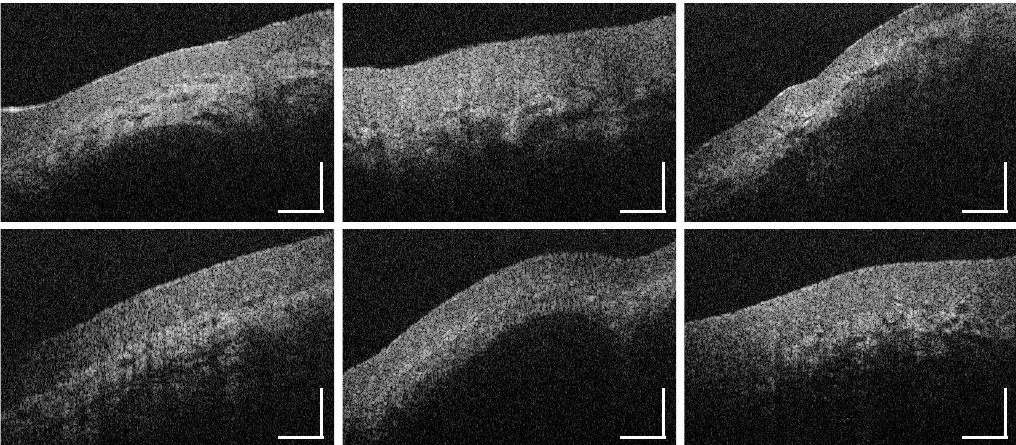
Figure A19. Supplementary intensity-based OCT cross sections of the oral mucosa of the anterior ventral tongue (MP9, Figure 1). Scale bars: 200 µ